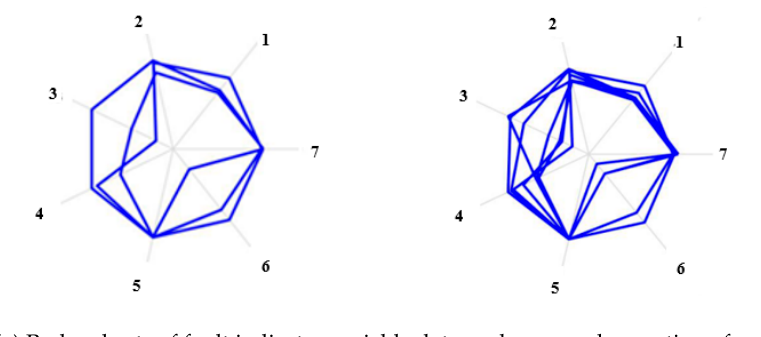
Figure 2. Schematic of wind turbine control system diagram. ( 1 ) Rotor; ( 2 ) main shaft; ( 3 ) gearbox; ( 4 ) brake system; ( 5 ) pitch control system; ( 6 ) generator; ( 7 ) power control to the grid; ( 8 ) low voltage switchgear; ( 9 ) low voltage switchgear; ( 10 ) converter system; ( 11 ) generator side converter;